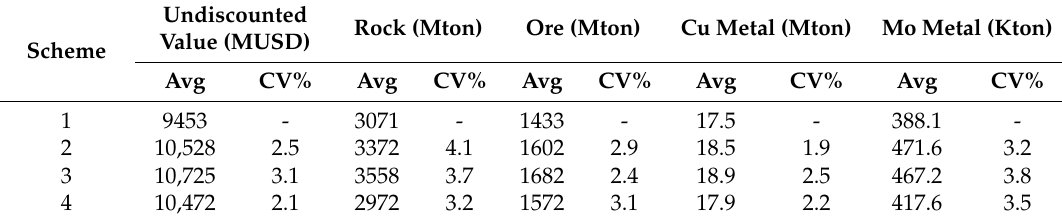
Table 5. Key indicators such as value, tonnages of rock, ore, Cu and Mo metal contents (average and coefficient of variation) from ultimate pit limits obtained by different schemes. The economic values for Schemes 1,2 and 4 were re-evaluated by using the economic model of Scheme 3 for comparison.